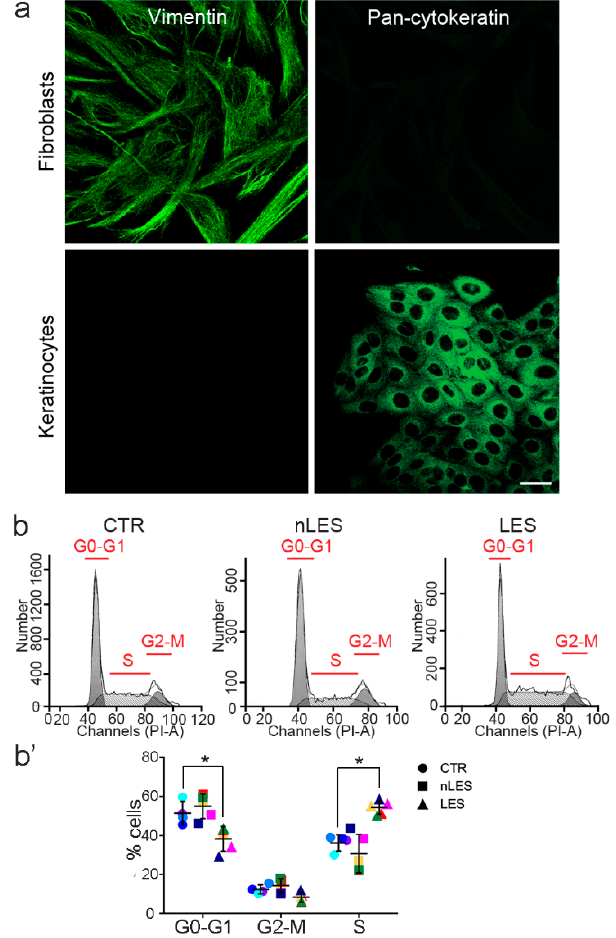
Figure 2. Fibroblasts were obtained from the skin of healthy volunteers (CTR) and from unaffected (nLES) and lesional (LES) skin areas of psoriatic patients; ( a ) Confocal microscopy analysis confirmed the purity of obtained fibroblasts cultures which were positive to anti-vimentin and negative to pan-cytokeratin immunocytochemical staining. ( b ) The cell cycle was analyzed by FACS Analysis in LES, nLES and CTR fibroblasts on their second passage. ( b’ ) Cells distribution quantification in G0-G1, G2-M and S phases of the cell cycle. In dot plot graphs, each patient/control is identified by a different color (see Table 3). Values are presented as means ± SD. Each experiment was performed in triplicate. * p < 0.05 vs. CTR. Scale bar = 20 µm.